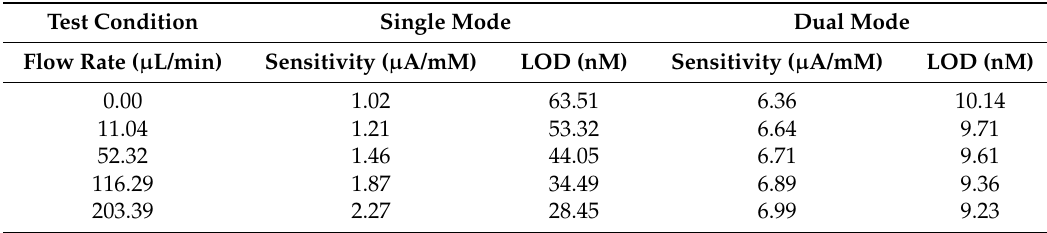
Table 3. Comparison of predicted and measured currents in dual mode at spin speed of 400 RPM at various concentrations.